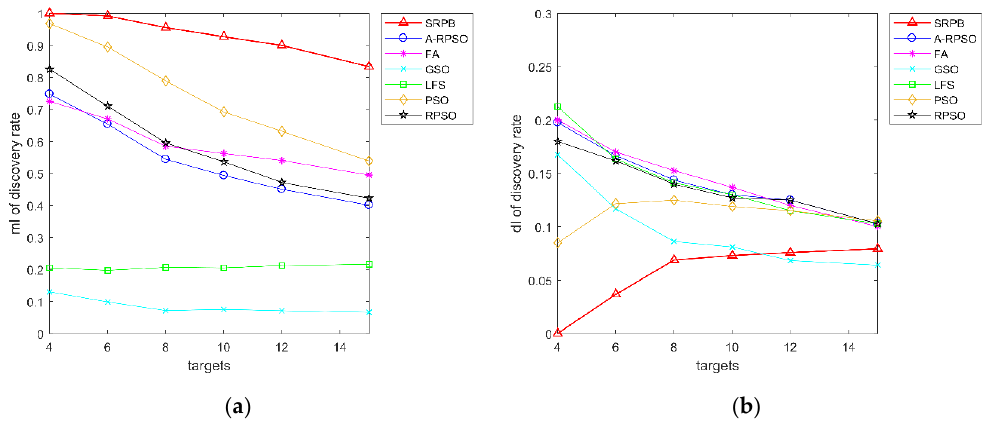
Figure 14. Discovery rate of the strategies. ( a ) mI of discovery rate; ( b ) dI of discovery rate.